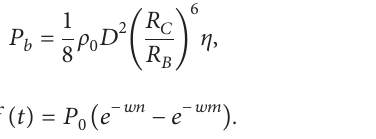
Figure 4: Simulation model of impact analysis of blasting vibration. (a) Numerical simulation meshing. (b) Mesh of cutting hole of the second hole. (c) Mesh of first hole lining